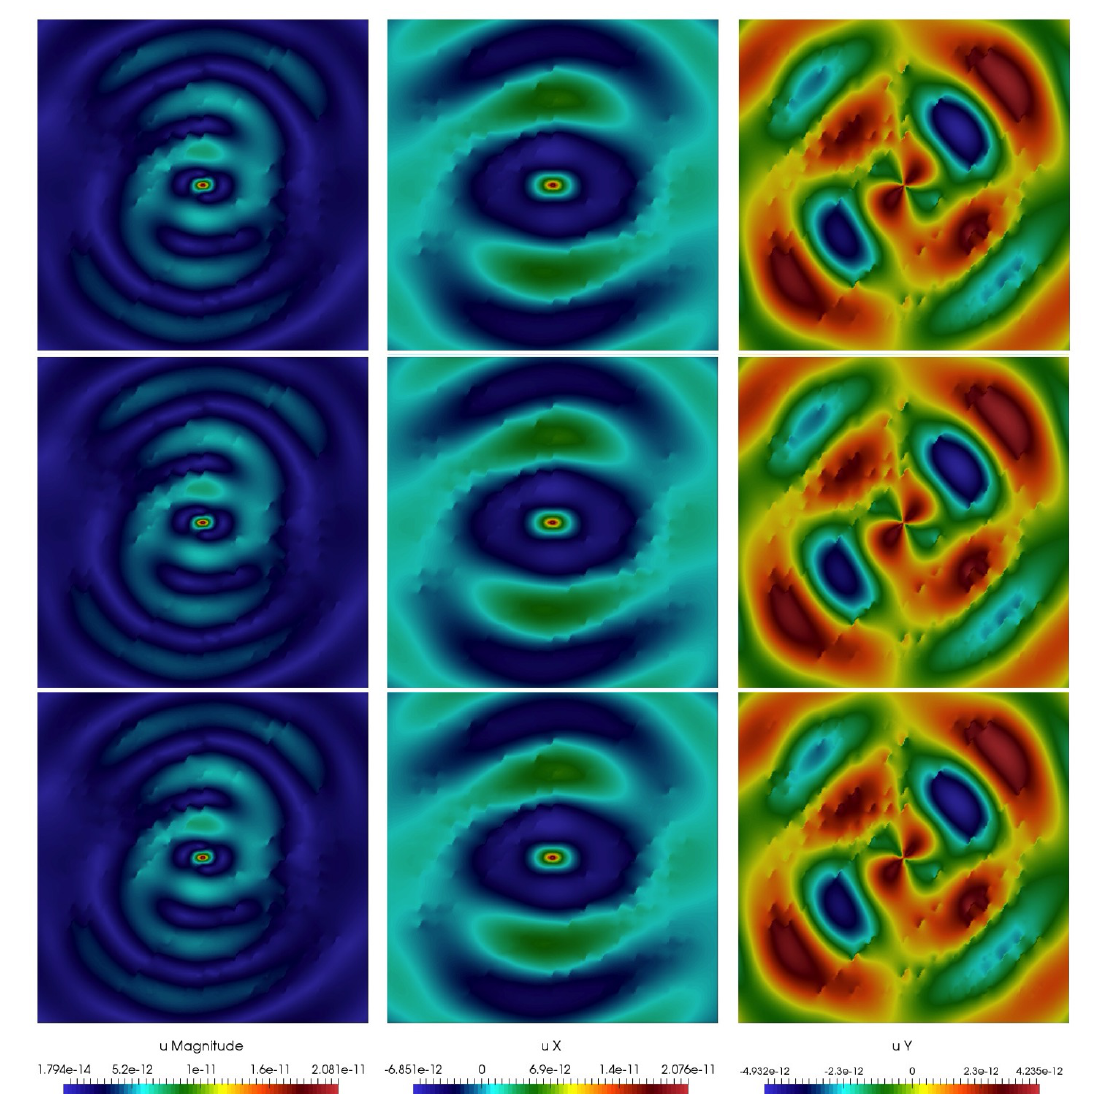
Figure 6. Numerical results for Geometry 2. Magnitude, X and Y components of displacement (from left to right). First row: reference (fine-grid) solution. Second row: multiscale solution using CG-GMsFEM. Third row: multiscale solution using